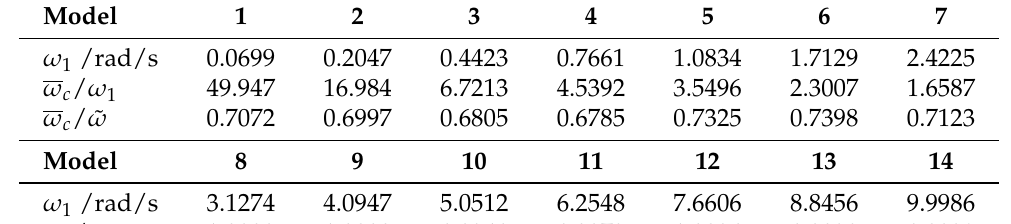
Table 2. Ratios of the average values of ω c to ω 1 and ˜ ω .